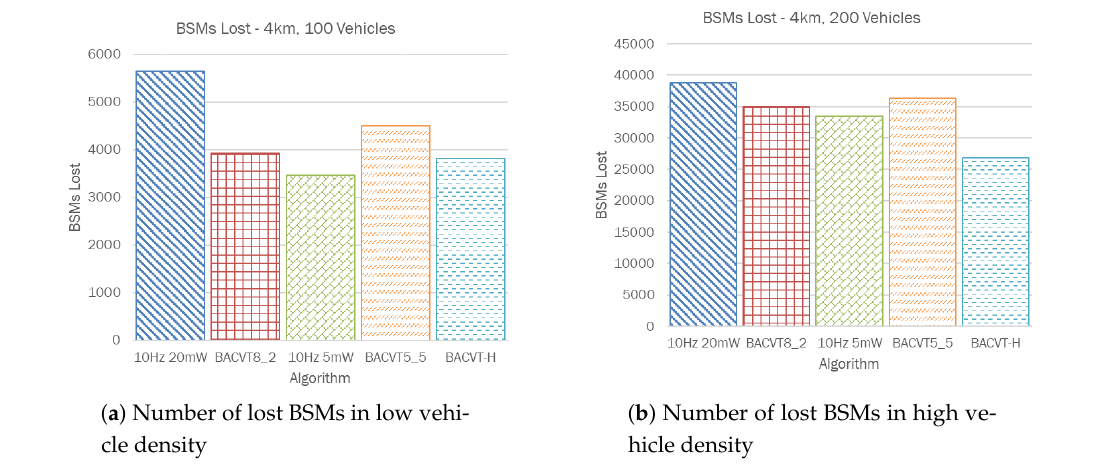
Figure 6. Number of lost BSMs in different vehicle densities.